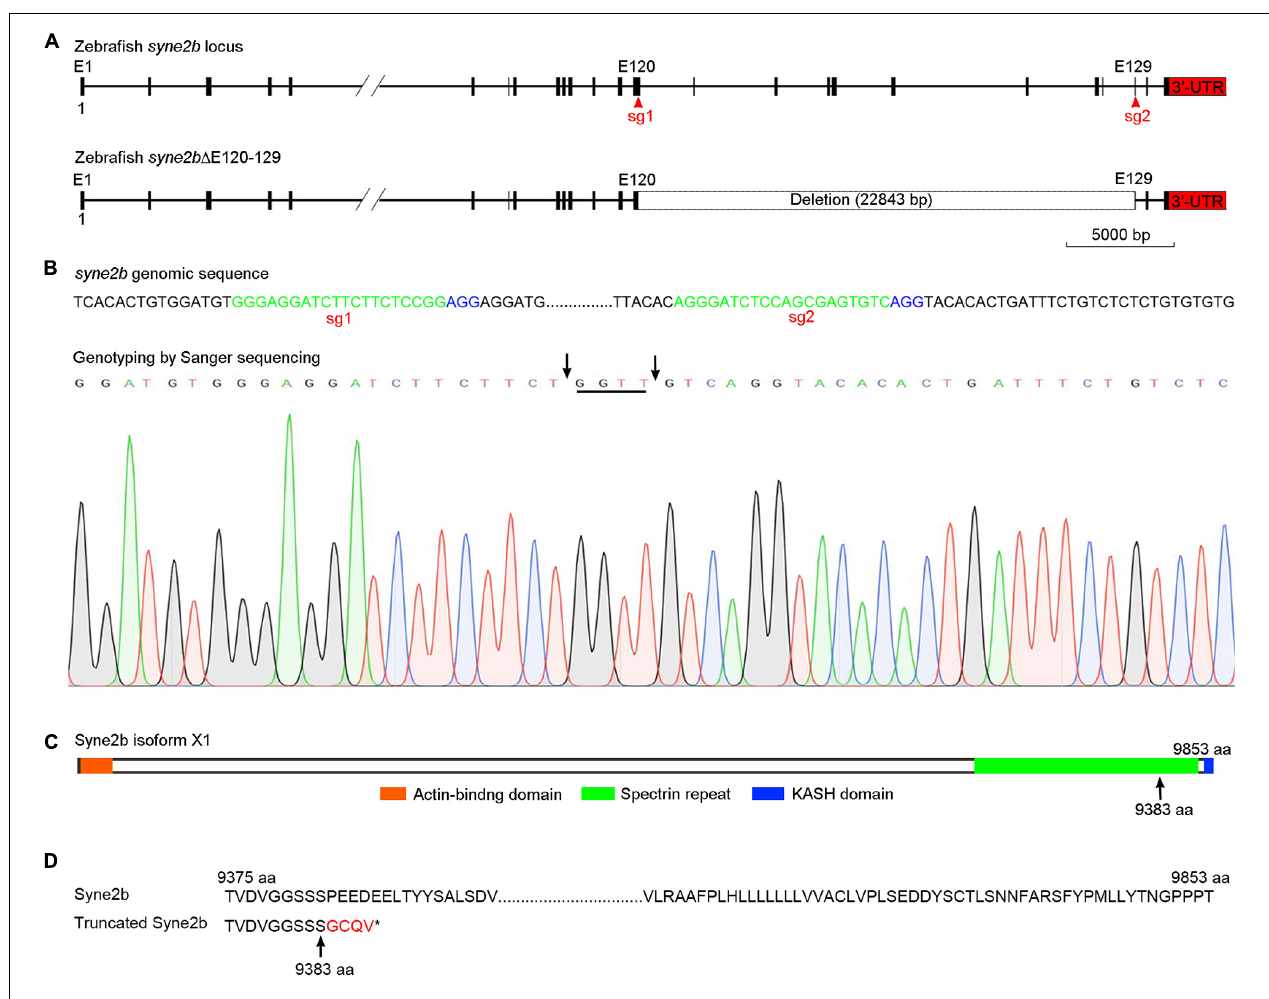
FIGURE 2 | Generation of syne2b mutation by CRISPR/Cas9-mediated genome editing. (A) Organization of the zebrafish syne2b locus. Shown are the sgRNA targeting sites (sg1 and sg2) and the deleted intervening region. (B) Genotyping of syne2b mutation. The sgRNA recognition sequences are green colored, and the PAM regions are shown in blue. Arrows indicate the positions of deletion in exons 120 and 129. Nucleotides inserted as a result of DNA repair are underlined. (C) Syne2b protein domains. Arrow indicates the position after which truncation occurs in the translated Syne2b protein. (D) Alignment of the C-terminal regions from wild-type and truncated Syne2b proteins. Residues translated after frameshift are indicated in